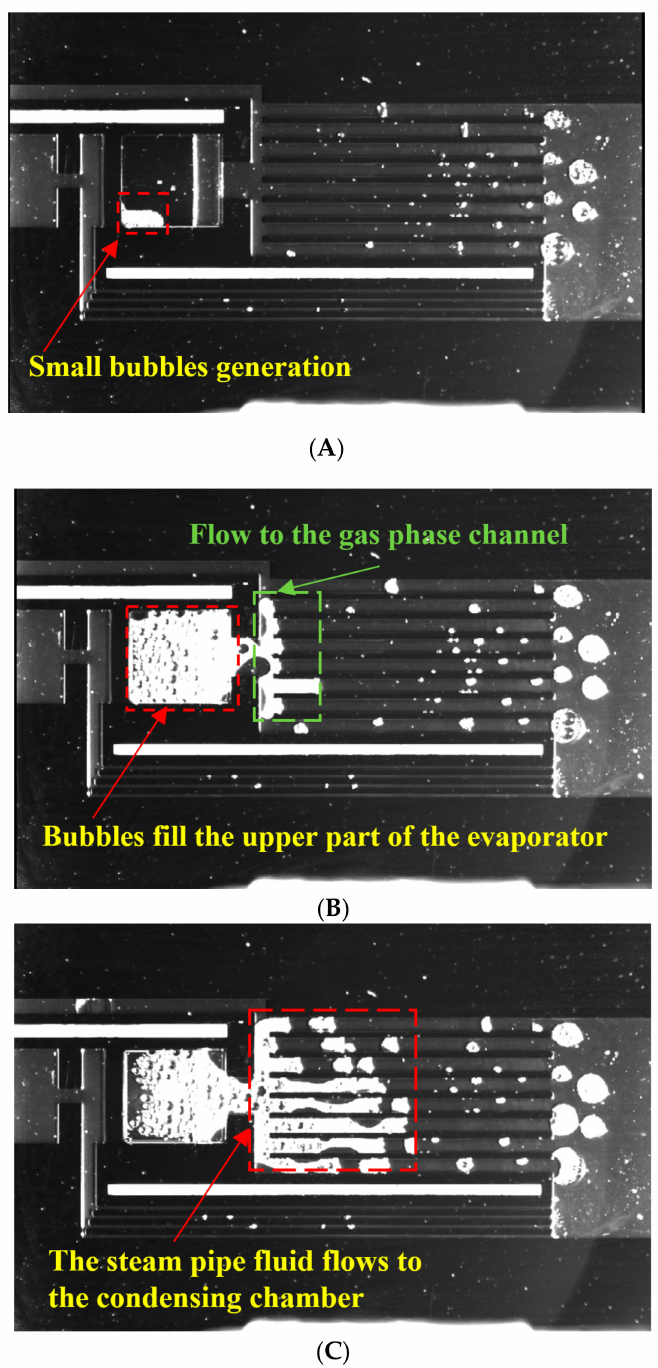
Figure 5. Startup process of the s-UTLHP with two different charging working fluids: ( A ) bubble generation stage at microchannel; ( B ) beginning stage of vapor outflow; ( C ) stable stage after vapor